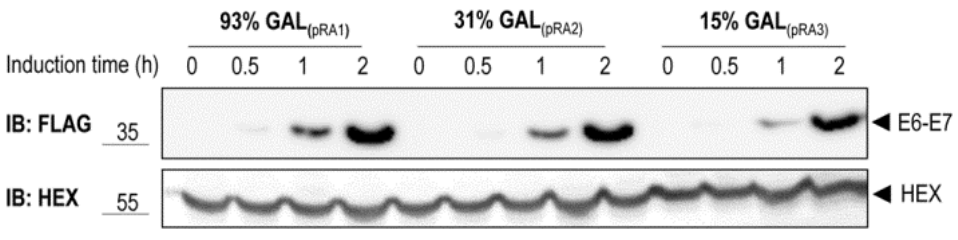
FIGURE 2: Galactose inducible expression of E6-E7. Yeast strain yRA2 transformed with E6-E7 cloned in pRA1 (Flag tag, URA3 marker, 93%- GAL1 promoter), pRA2 (Flag tag, URA3 marker, 31%-GAL1 promoter) and pRA3 (Flag tag, URA3 marker, 15%-GAL1 promoter), was induced for the indicated time points by the addition of 2% galactose. Cells were lysed and equivalent amounts of protein extract were analyzed by SDS- PAGE and anti-Flag immunoblotting. Hexokinase is used as a loading